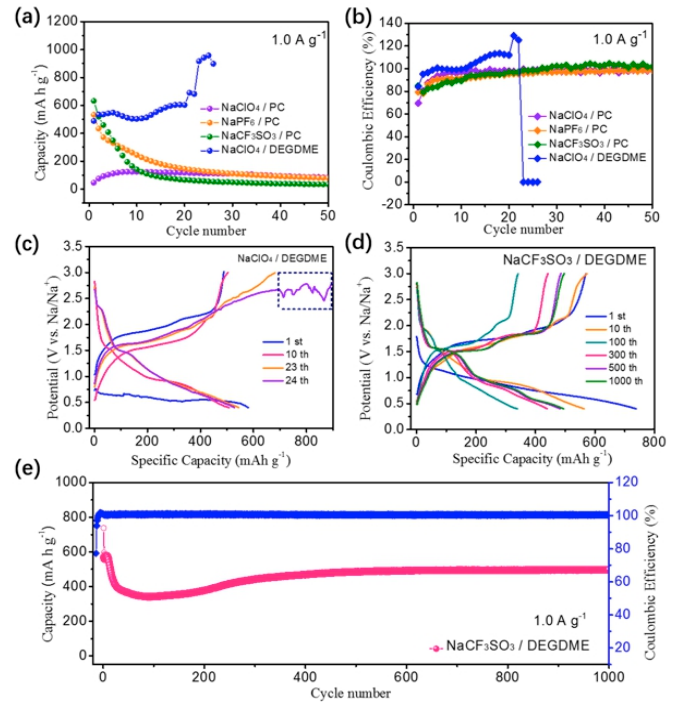
Figure 11. ( a , c ) Cycling performances and ( d ) coulombic efficiency of the anode composed of NiCo 2 S 4 nanodots (9 nm) and N-doped carbon in di ff erent electrolytes at the current density of 1.0 A · g − 1 nanodots (9 nm) and N-doped carbon in different electrolytes at the current density of 1.0 A g − 1 . The galvanostatic discharge-charge profiles in ( b ) NaCF 3 SO 3 /DEGDME and ( e ) NaClO 4 /DEGDME electrolytes. Reproduced with permission from [296]. Copyright 2011 Wiley.